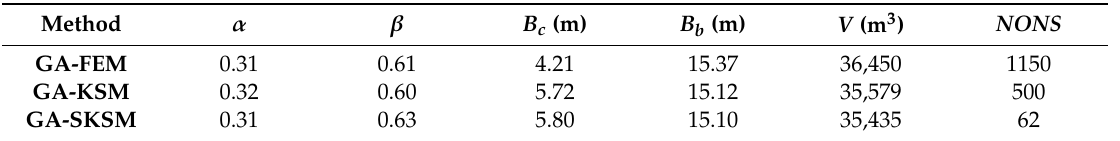
Table 3. Optimal designs of the single-curvature arch dam obtained using the generic algorithm finite element method (GA-FEM), GA-KSM, and